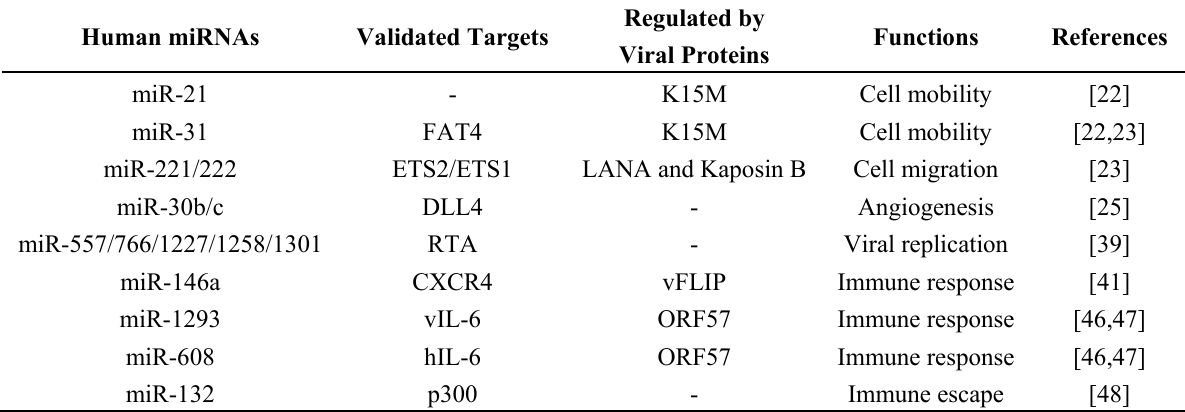
Table 1. Overview of human miRNAs regulated by KSHV/viral